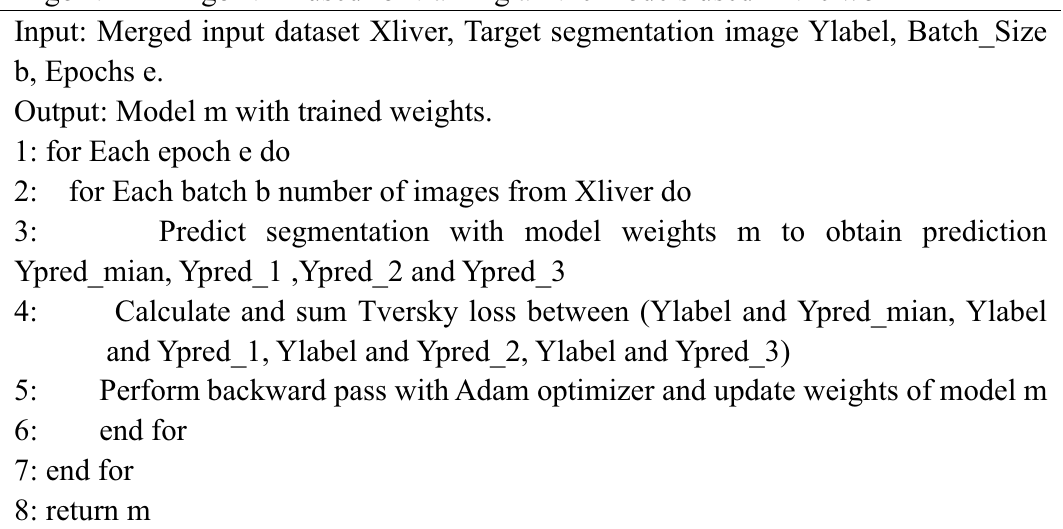
Algorithm 1 Algorithm used for training all the models used in the work